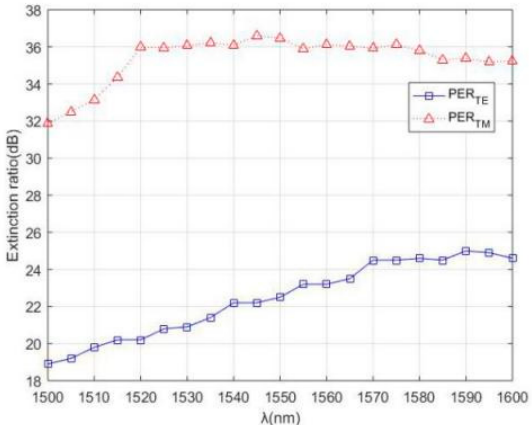
Figure 10. PER of outputs TE and TM over the band ë = 1500–1600 nm.